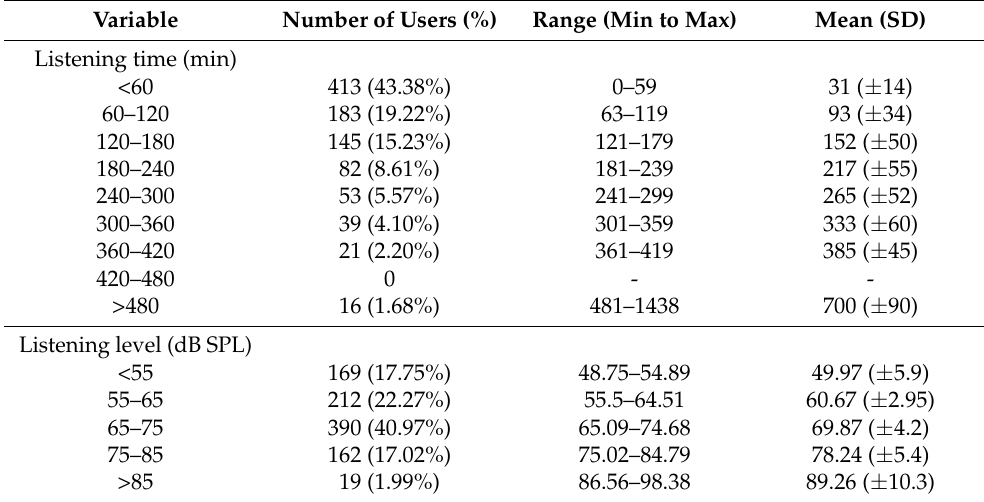
Table 2. Number and percentage of subjects for a sub-group of listening levels and time (N =